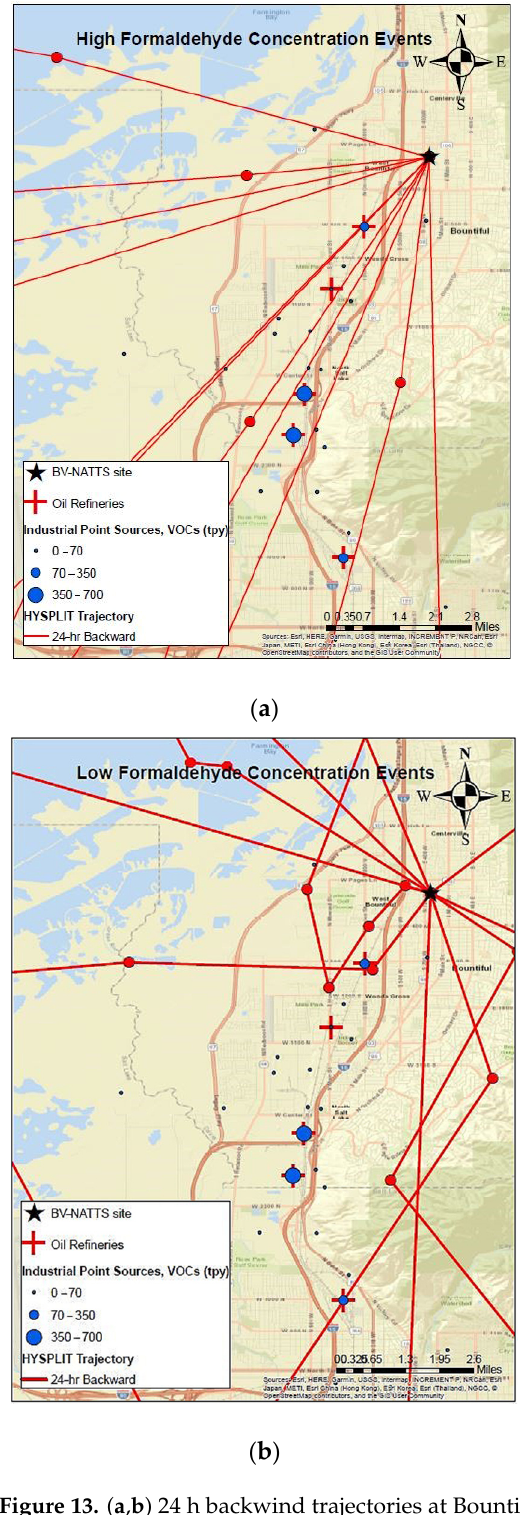
Figure 13. ( a , b ) 24 h backwind trajectories at Bountiful monitoring station during ( a ) high and ( b ) low formaldehyde concentration events. Red circles represent hourly positions for each trajectory. Green color represents mountains with forested areas.